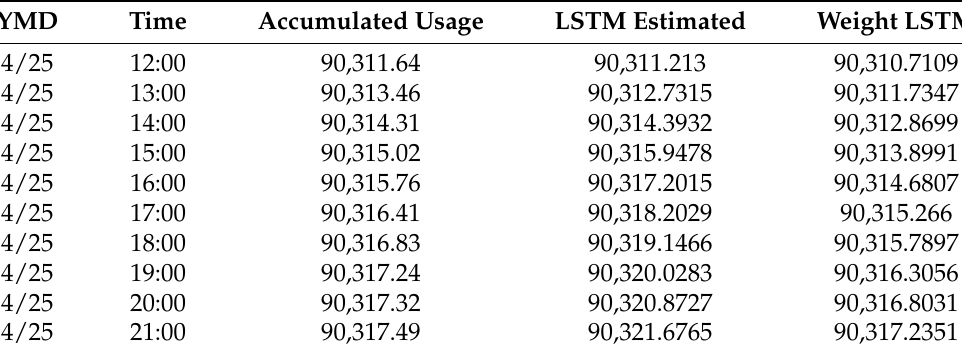
Table 11. Example of errors in data corrected using the LSTM